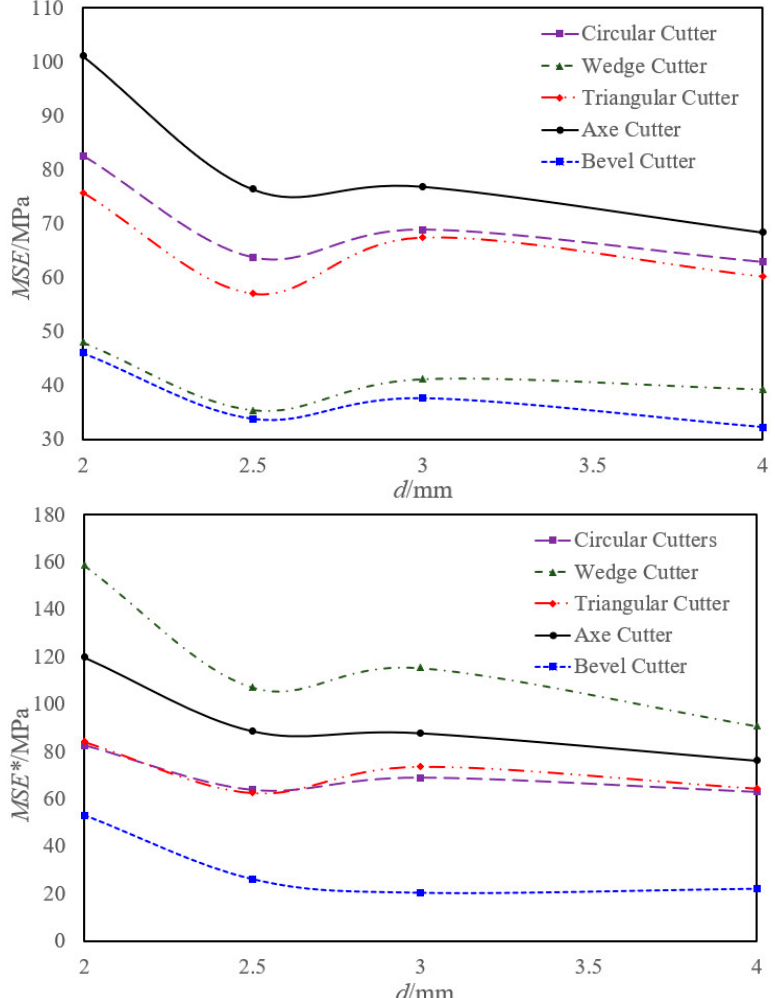
Figure 8. Numerical simulation results of the MSE and MSE *. The top subfigure is the curve of the MSE with d ; the bottom subfigure is the curve of MSE * with d.